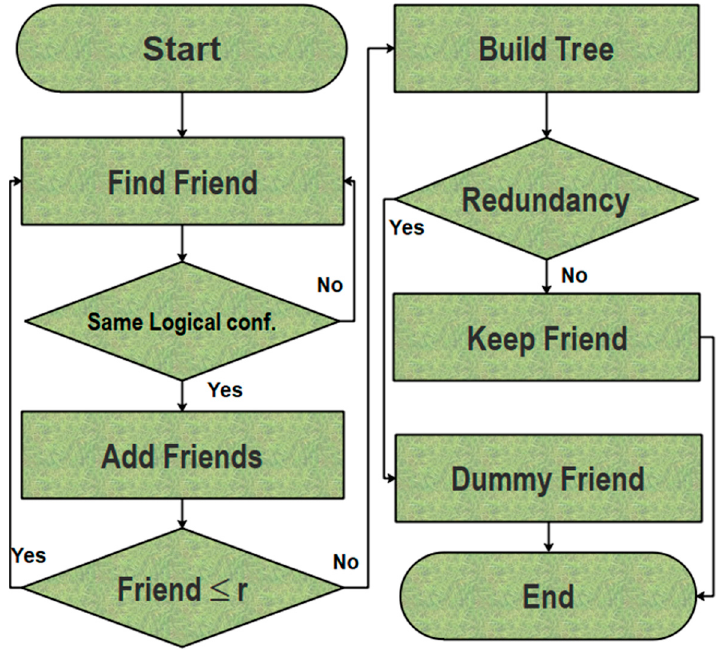
Figure 2. The friend selection for an individual’s small world. Algorithm 1. The friendship selection algorithm.